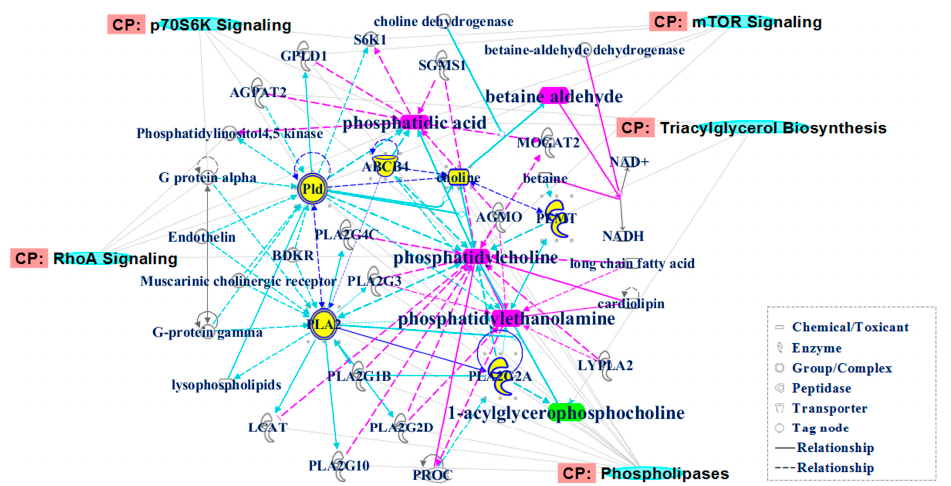
Figure 3. Biological network and canonical pathways related to the identified common metabolites. In the network, molecules are represented as nodes, and the biological relationship between two nodes is represented as a line. Red symbols represent up-regulated metabolites; green symbols represent down-regulated metabolites; yellow symbols are the high link molecules from the Ingenuity Knowledge Database, while the blue symbols represent canonical pathways that are related to the identified specific metabolites. Solid lines between molecules show a direct physical relationship between molecules, while dotted lines show indirect functional relationships.